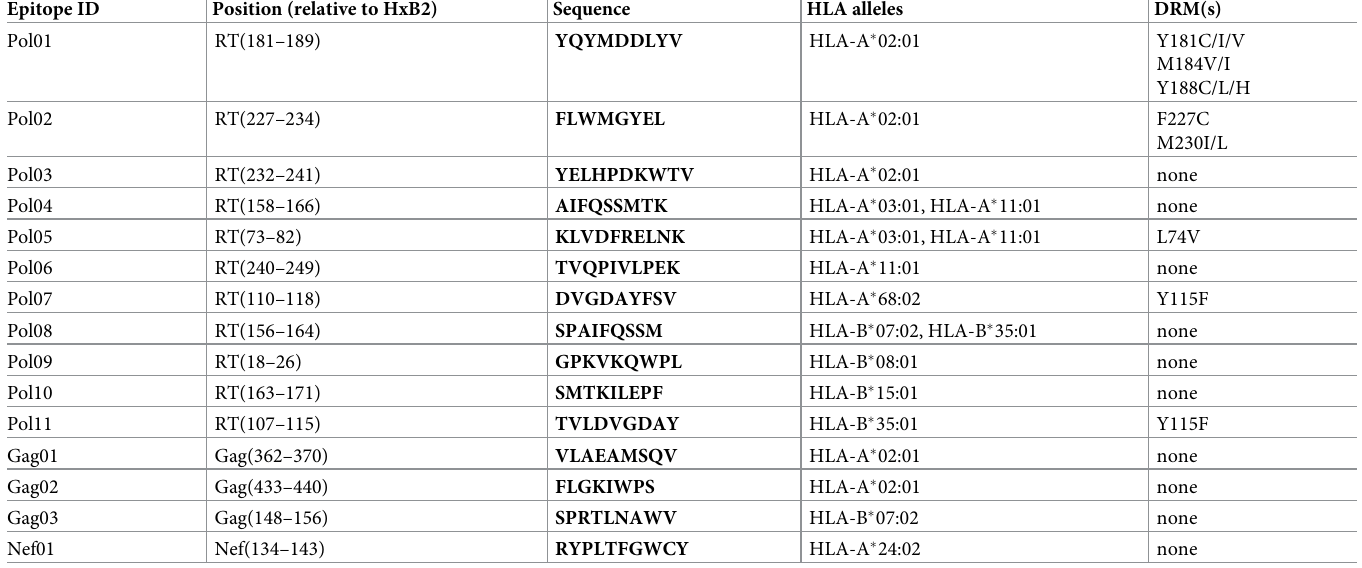
Table 2. List of epitopes identified in the study. For each epitope, its position (gene and position according to the HxB2 reference), the aminoacid sequence, the HLA allele(s) predicted to have a high affinity to the epitope and the eventual presence in the epitope of drug resistance-associated mutation(s): DRM(s) according to IAS–USA DRM list